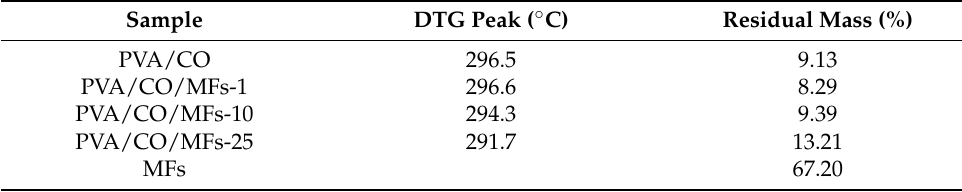
Figure 4. TGA and DTG curves of MFs and magnetic hydrogels. Table 1. TGA and DTG results for the magnetic